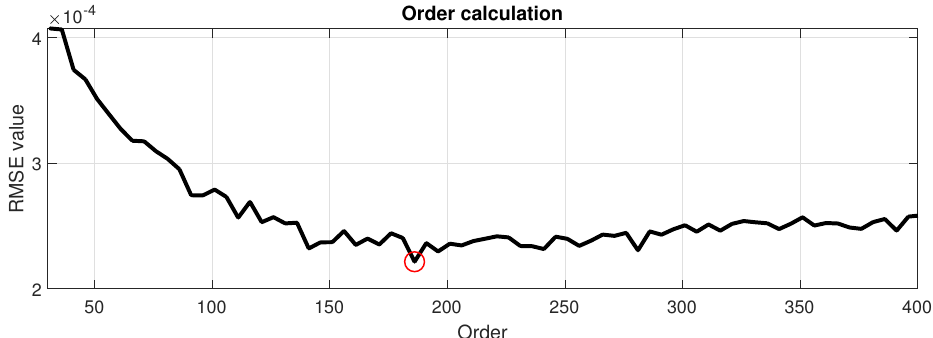
Figure 13. The values of RMSE error for predefined range of AR order p .